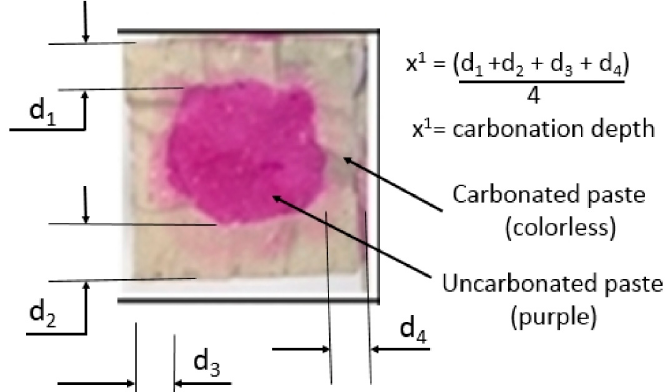
Figure 5. Measuring the carbonation depth of paste blocks.